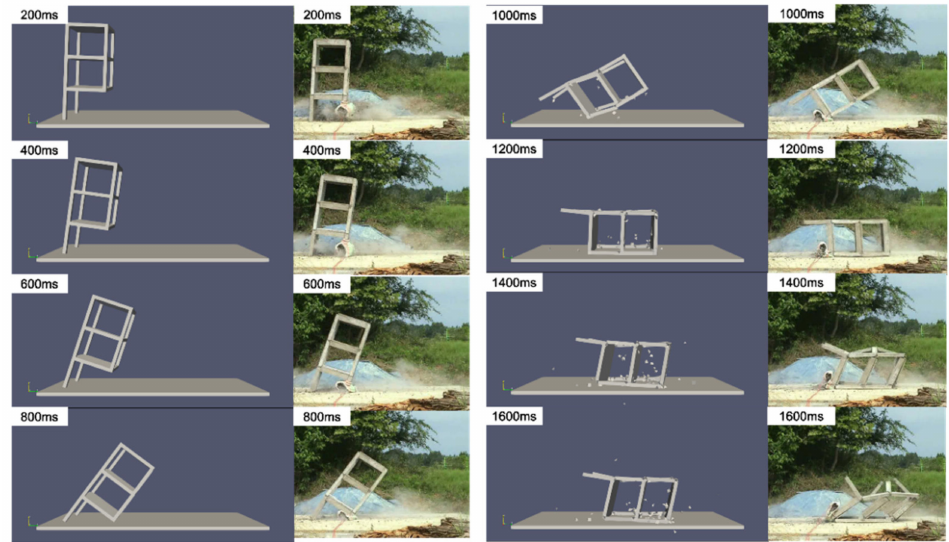
Figure 15. Comparison of 3D-FDEM ( left-side ) and experiment ( right-side ) results from the demo- lition of a small-scale RC structure (This figure has been reproduced from [7] under the terms and conditions of the CC BY-NC